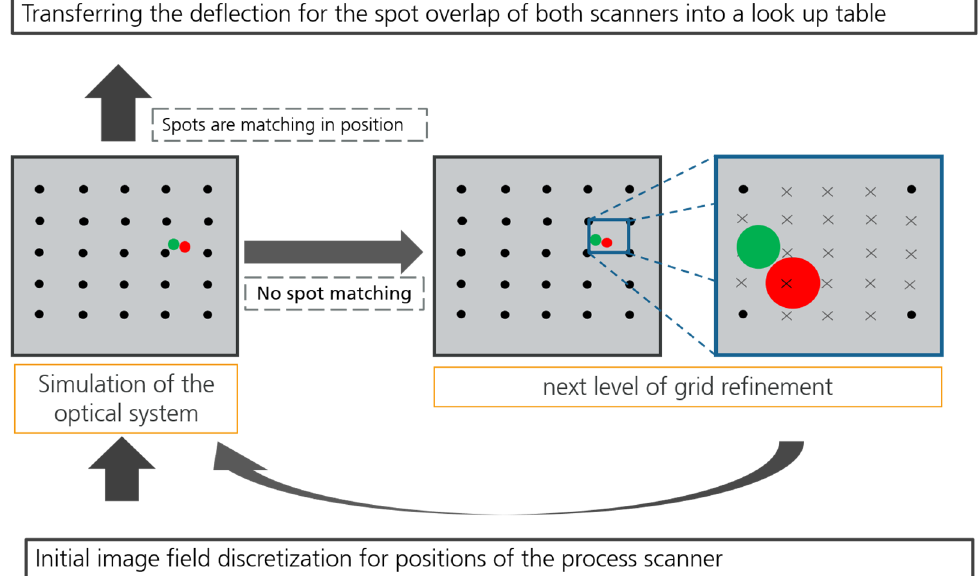
Figure 9. Illustration of the iterative procedure for determining the correction values of the lookup table. Simulations are performed in various degrees of refinement until a spot coverage is achieved.